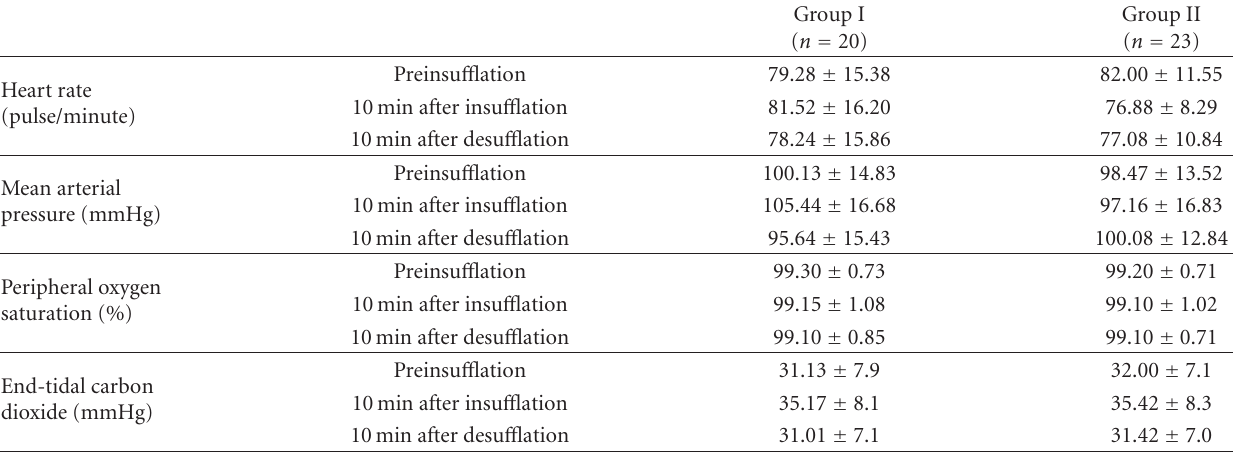
Table 2: Hemodynamic variables.